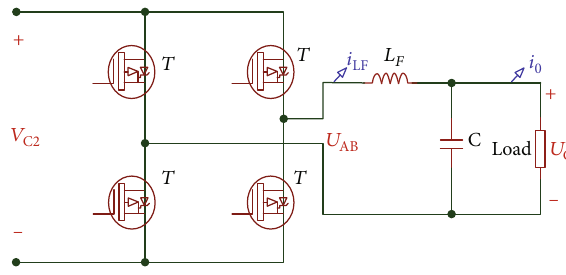
Figure 8: Basic schematic of a single-phase H-bridge